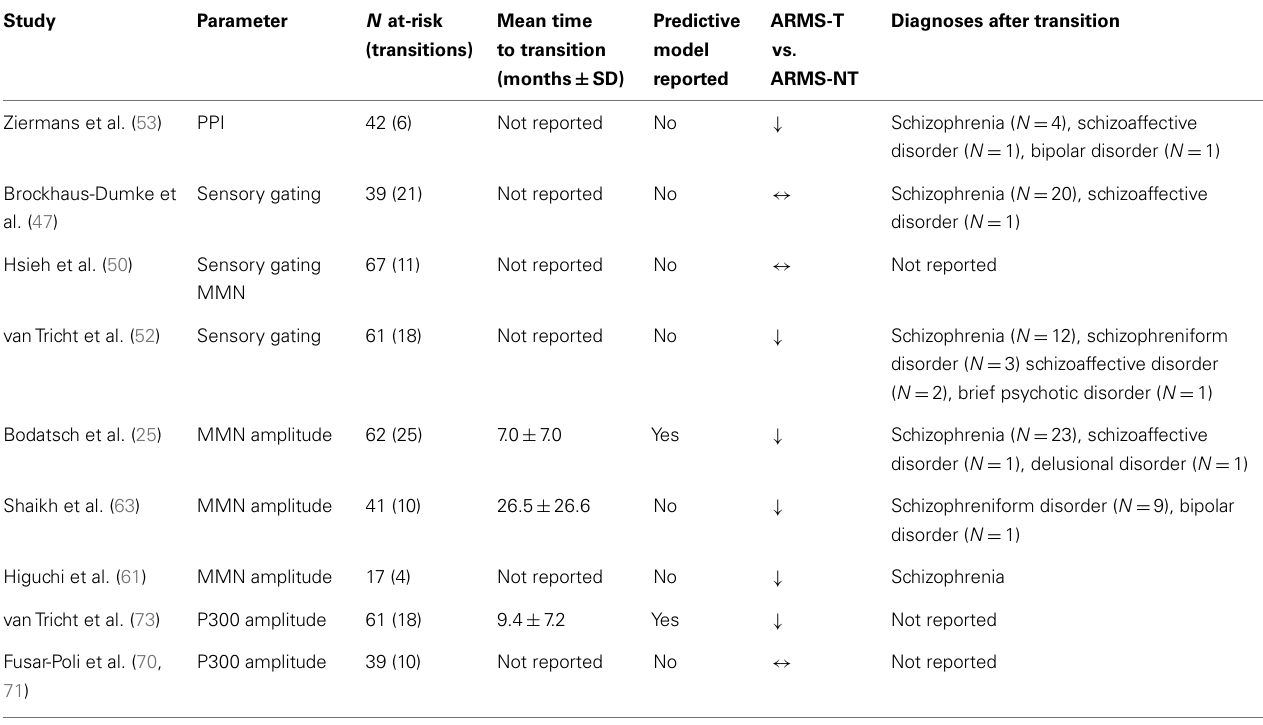
Table 2 | Event-related potentials and prepulse inhibition in converters and